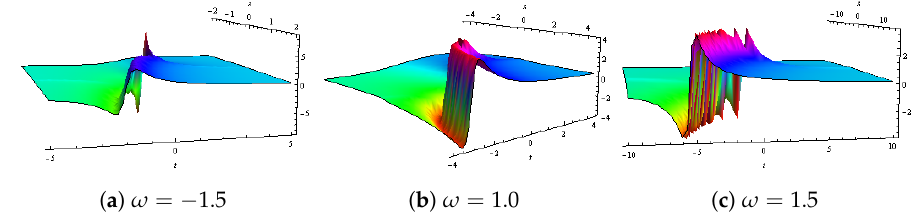
Figure 14. ( a – c ) show 3D